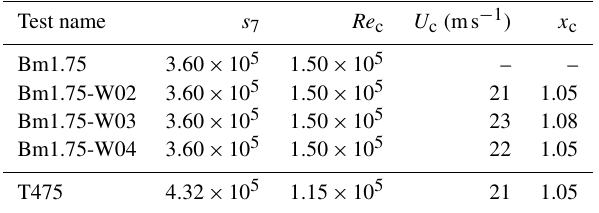
Table 2. Tests for wind correction and swell dissipation parameters. All parameters not specified here correspond to the T475 parame- ter adjustment detailed by Alday et al. (2021). Variables Re c , U c , and x c correspond to namelist parameters SWELLF7, SWELLF4, WCOR1, and WCOR2 in the WW3 input files (see Appendix A for the full set of parameters). The directional discretization has 24 directions in all of these